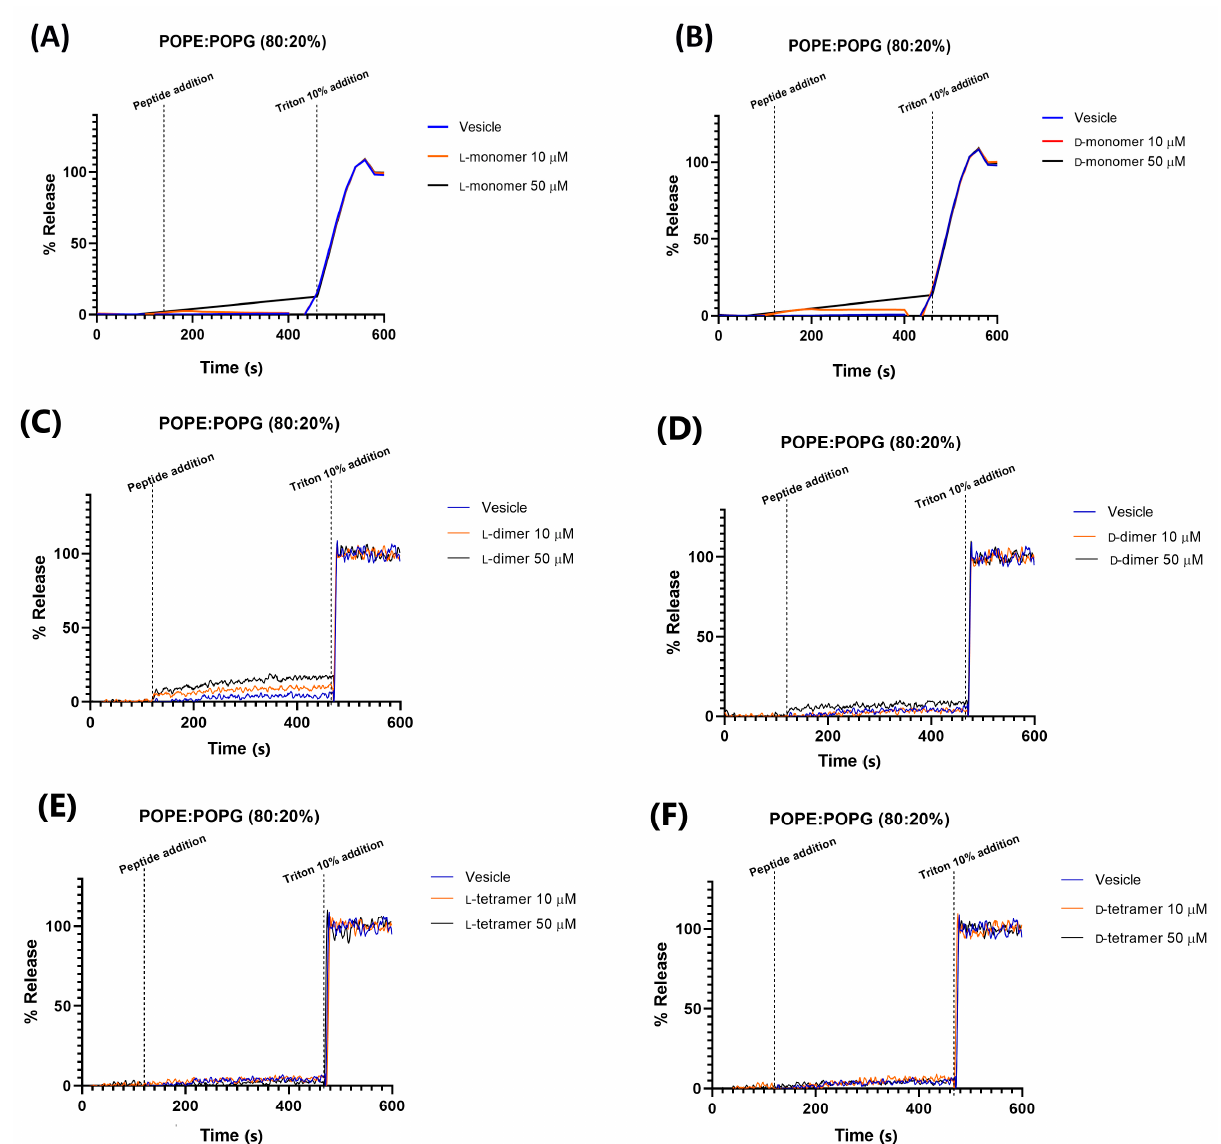
Figure 6. Permeabilization in 80% POPE and 20% POPG vesicles of the peptides: ( A ) L-monomer, ( B ) D-monomer, ( C ) L-dimer, ( D ) D-dimer, ( E ) L-tetramer, and ( F ) D-tetramer at concentrations of 10 and 50 μ M.